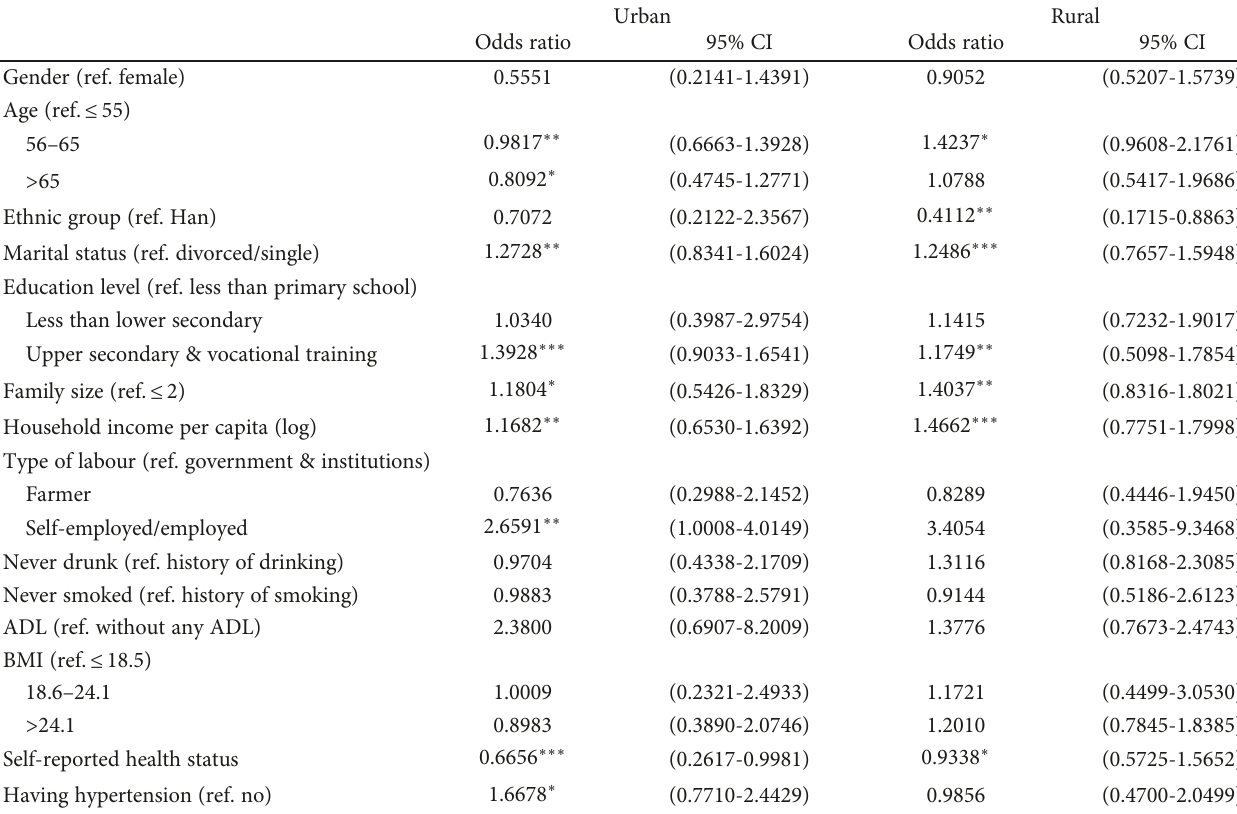
Table 5: Logistic regression model on incidence of receiving antidiabetic medication among middle-aged and elderly diabetes